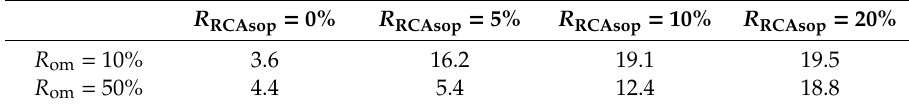
Table 4. The D RAC ( × 10 − 12 m 2 / s) corresponding with Figure